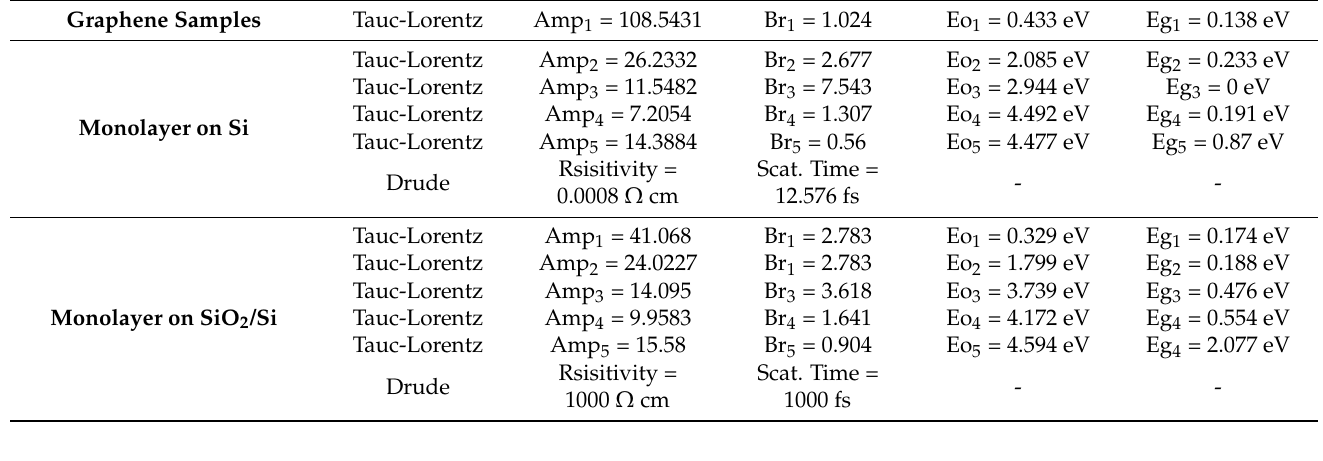
Table 2. The fitting parameters of Tauc-Lorentz and Drude oscillators for monolayer graphene on Si and SiO 2 /Si substrates (300 K).